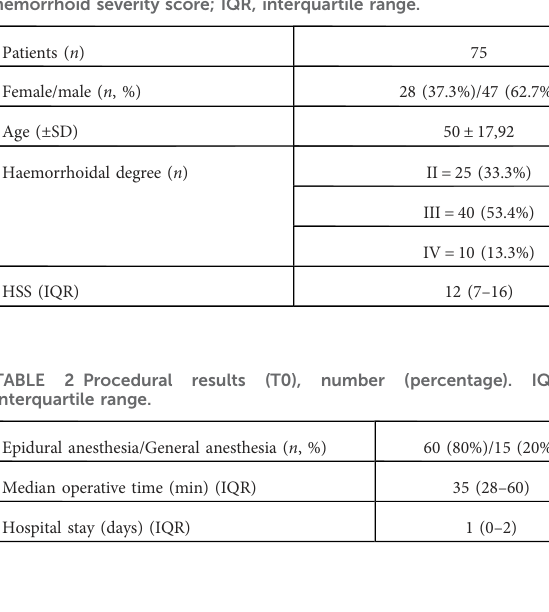
TABLE 1 Patients ’ characteristics. SD, standard deviation; HSS, hemorrhoid severity score; IQR, interquartile range.